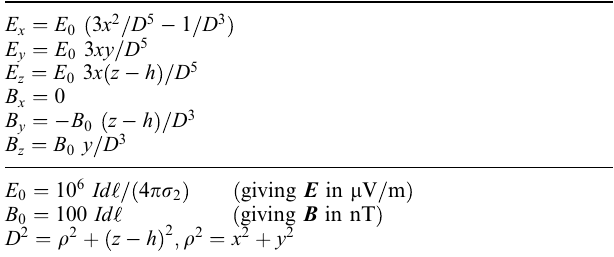
Table 1. Layer-2 primary fields of the HED E x (cid:136) E 0 (cid:133) 3 x 2 = D 5 (cid:255) 1 = D 3 (cid:134) E